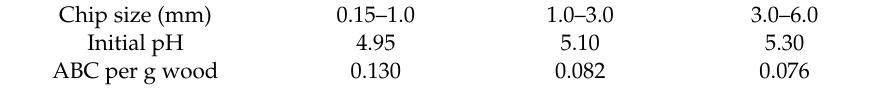
Figure 3. The effect of chip size on the pH in suspension (pine chips, 60 min latency time, end point pH 4). Table 2. Acid buffering capacity (ABC) per gram of woody material.